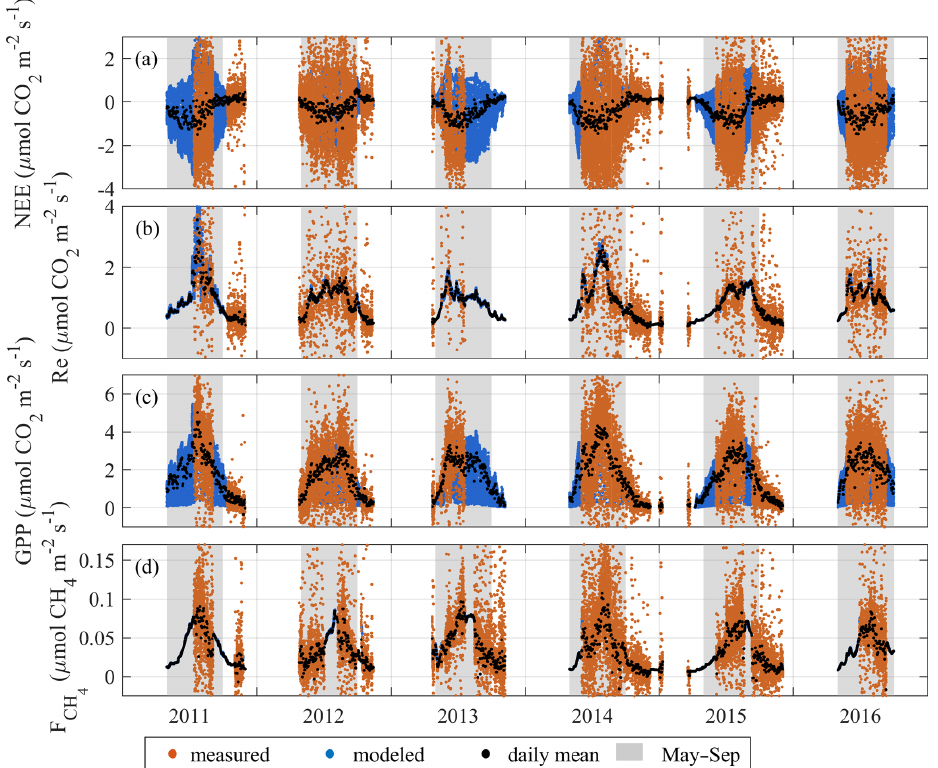
. The gray shading highlights the growing season 4